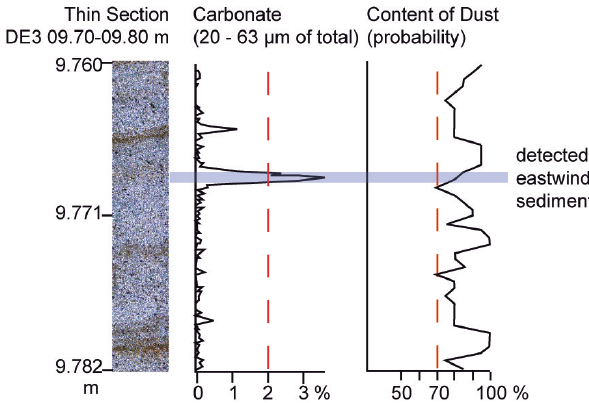
Fig. 2. Scatter plot of the weighted carbonate-quartz test samples versus the area percentage of detected carbonate particles. A calcu- lated correlation coefficient ( R 2 ) of 0.94 shows the reliable detec- tion and classification of carbonates by the RADIUS particle analy- sis system.